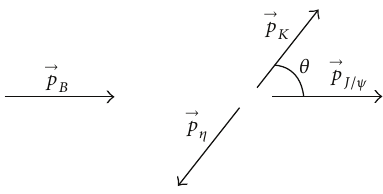
Figure 3: Definition of helicity angle 𝜃 , for the decay 𝐵 → 𝐽/𝜓𝜂𝐾